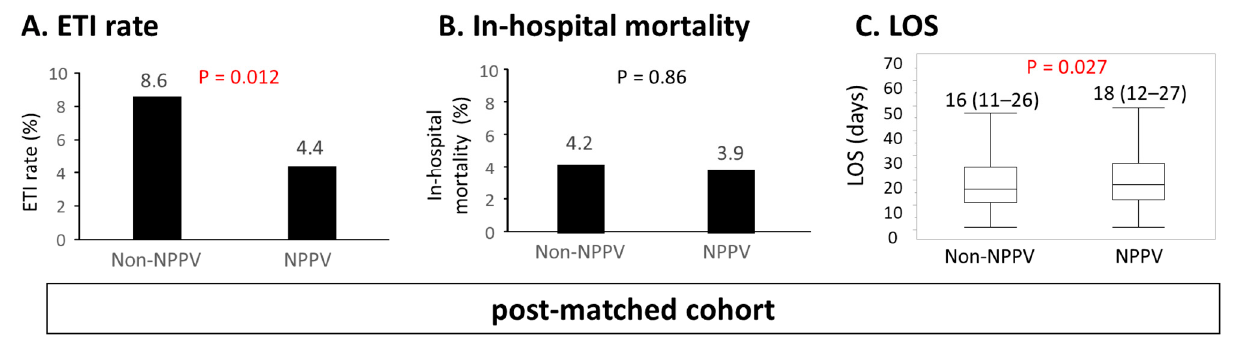
Figure 2. In-hospital outcomes in the post-matched cohort. ( A ) ETI rate, ( B ) in-hospital mortality, and ( C ) LOS in the post-matched cohort are depicted. ETI, endotracheal intubation; NPPV, non-invasive positive pressure ventilation; LOS, length of hospital stay.